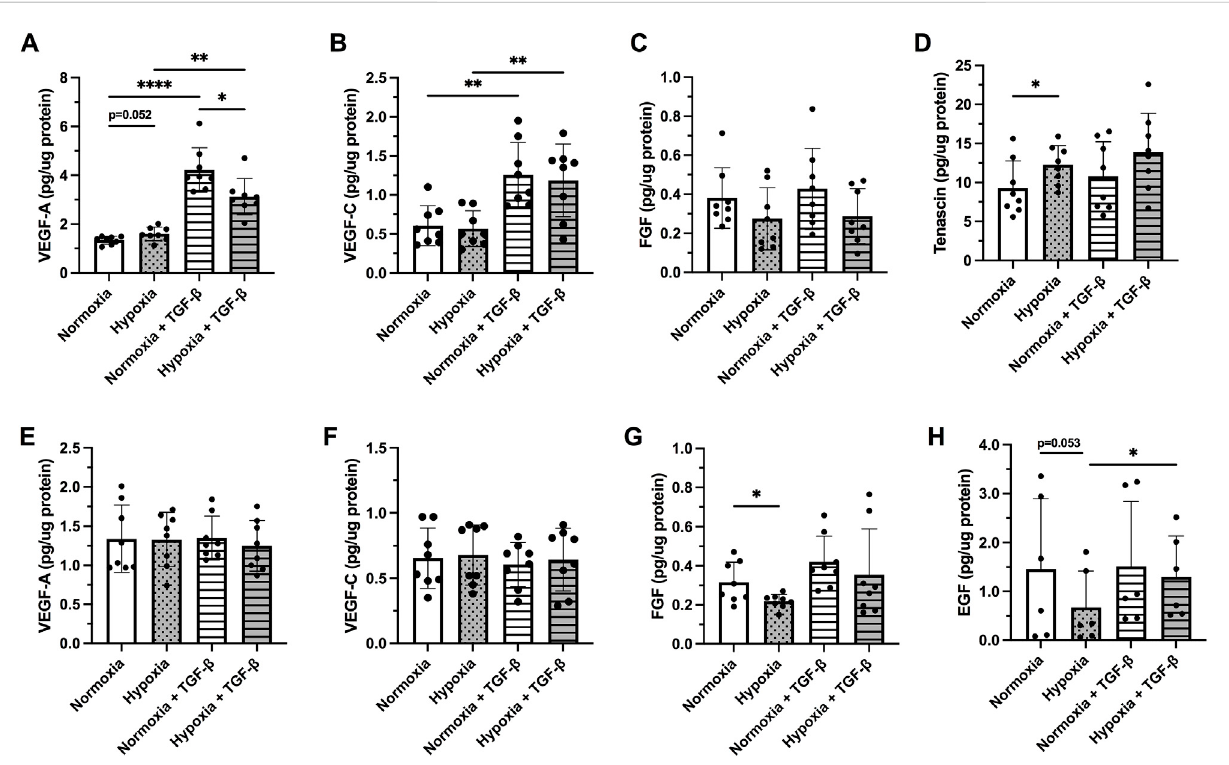
FIGURE 3 Release of following growth factors: Vascular endothelial growth factor (VEGF)-A (A,E) and VEGF-C (B,F) , fi broblast growth factor (FGF) basic (C,G) , Tenascin C (D) and epidermal growth factor [EGF, (H) ] were investigated in BEAS-2B (A – D) and hAELVi (E – H) cells exposed 24 h to normoxia or hypoxia withorwithoutTGF- β 1(10 ng/ml)stimuli.Thetotalamountofreleasedgrowthfactorwasnormalizedtototalproteinamountforeachindividualsample. Dataispresentedfromfourindividualexperiments,includingtwobiologicalreplicatesfromeachexperiment( n =8intotal).Thedataispresentedas mean±SD.StatisticalanalysiswasperformedwithOne-wayRMANOVAfollowedby post-hoc analysiswithFisher ’ sLSDtest.* p < 0.05,** p < 0.01,*** p < 0.001, **** p <